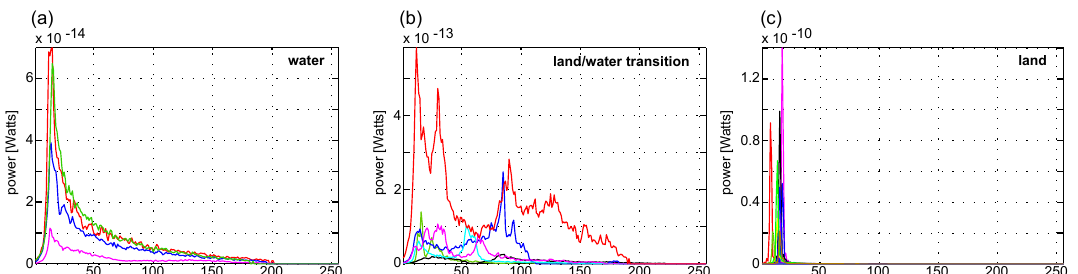
Figure 3. Shape of the shifted waveforms of the thirty clusters which are assigned into the three classes: ( a ) water (includes 4 clusters); ( b ) land-water transition (includes 6 clusters) and ( c ) land (includes 20